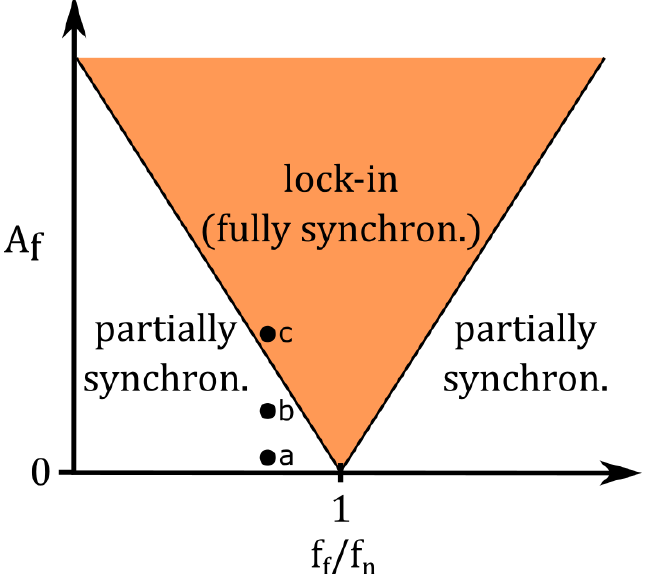
Figure 4. Sketch of a simplified lock-in diagram describing a periodically forced model oscillator. The actuation amplitude A f is presented as a function of the normalized actuation frequency f f / f n . Orange area: lock-in (phase and frequency fully